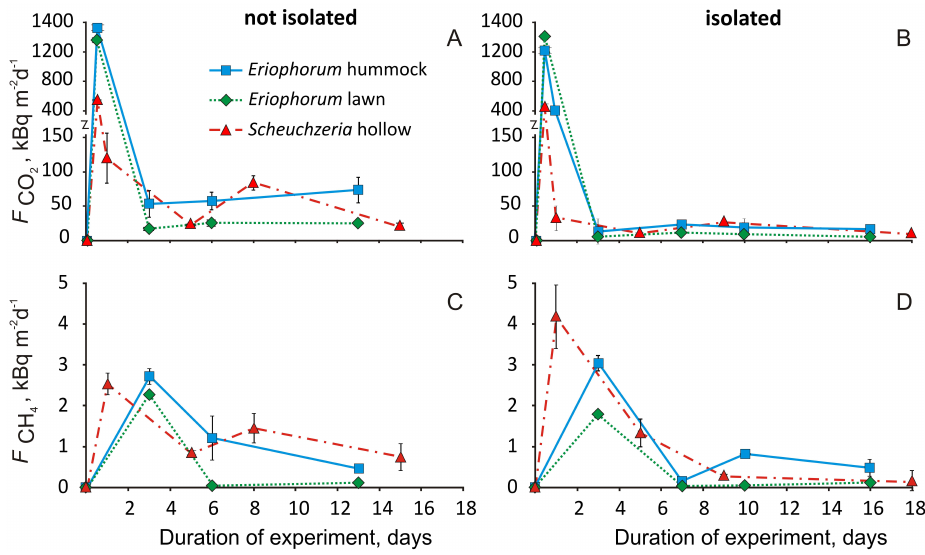
Fig. 4. Fluxes of labeled carbon dioxide ( F 14CO mesocosms of E . vaginatum from hummocks and lawns and S. palustris from hollows during 18 days of the experiment. Errors are standard errors of measurement ( n =